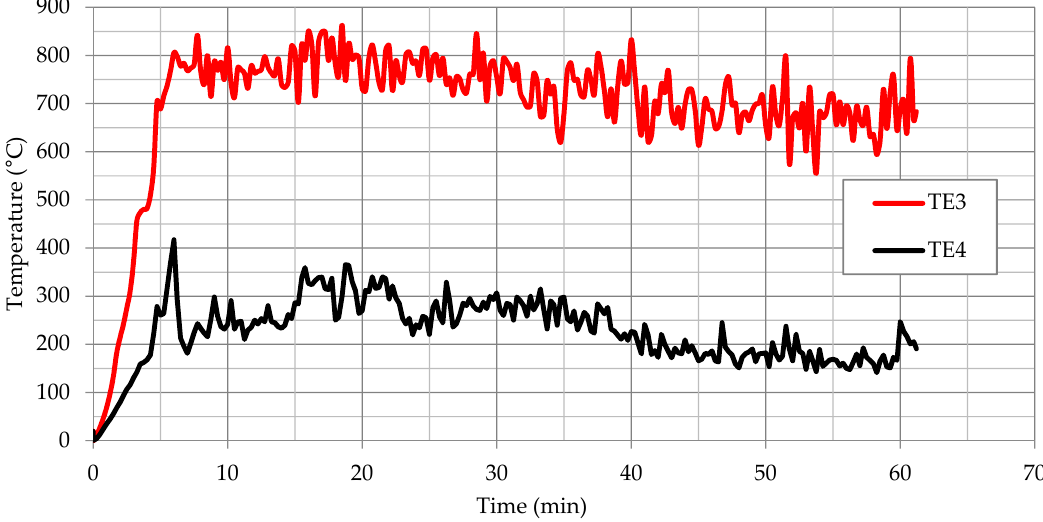
Figure 7. Temperature measurement results for TE3 and TE4 thermocouples.